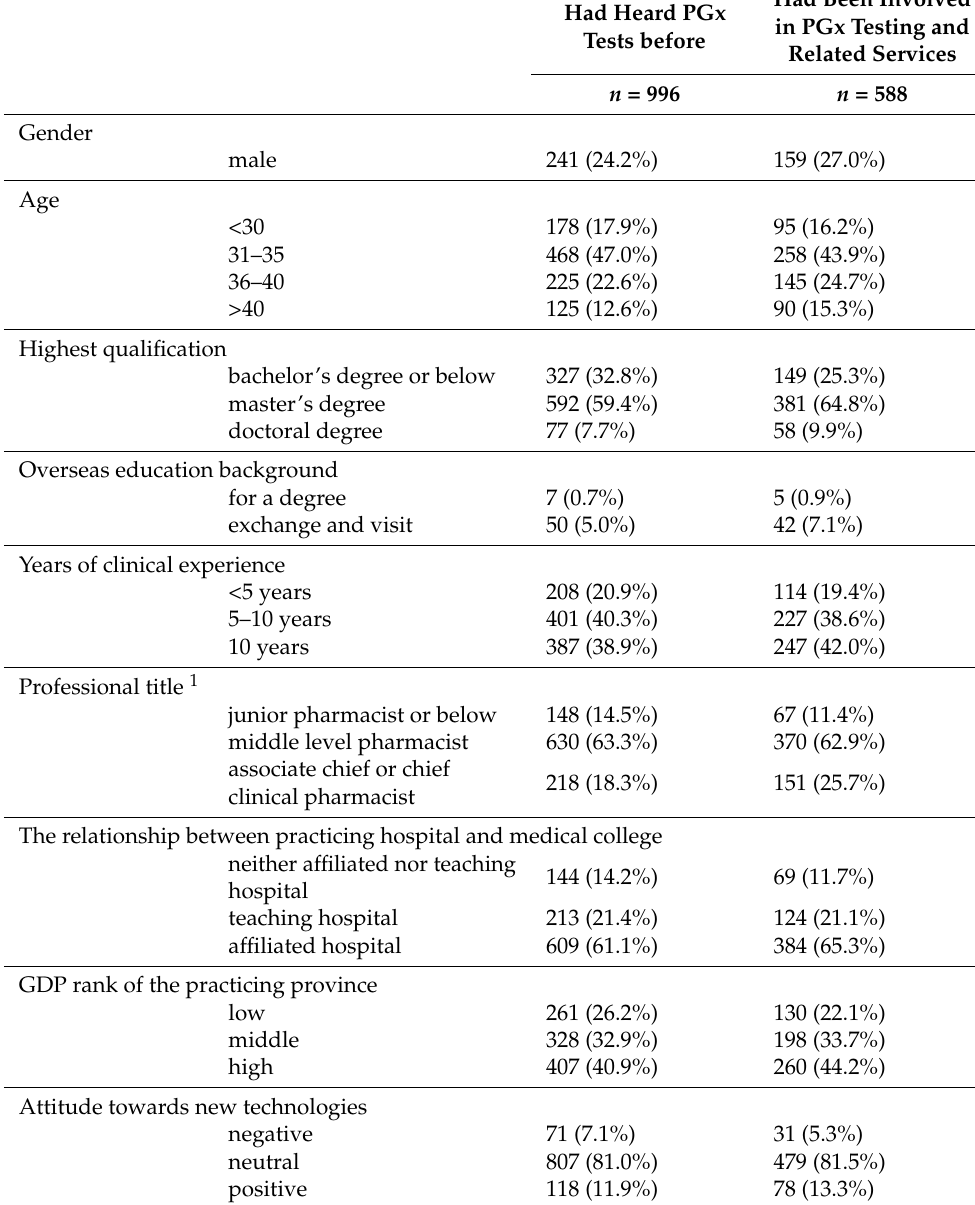
Table 1. Characteristics of study